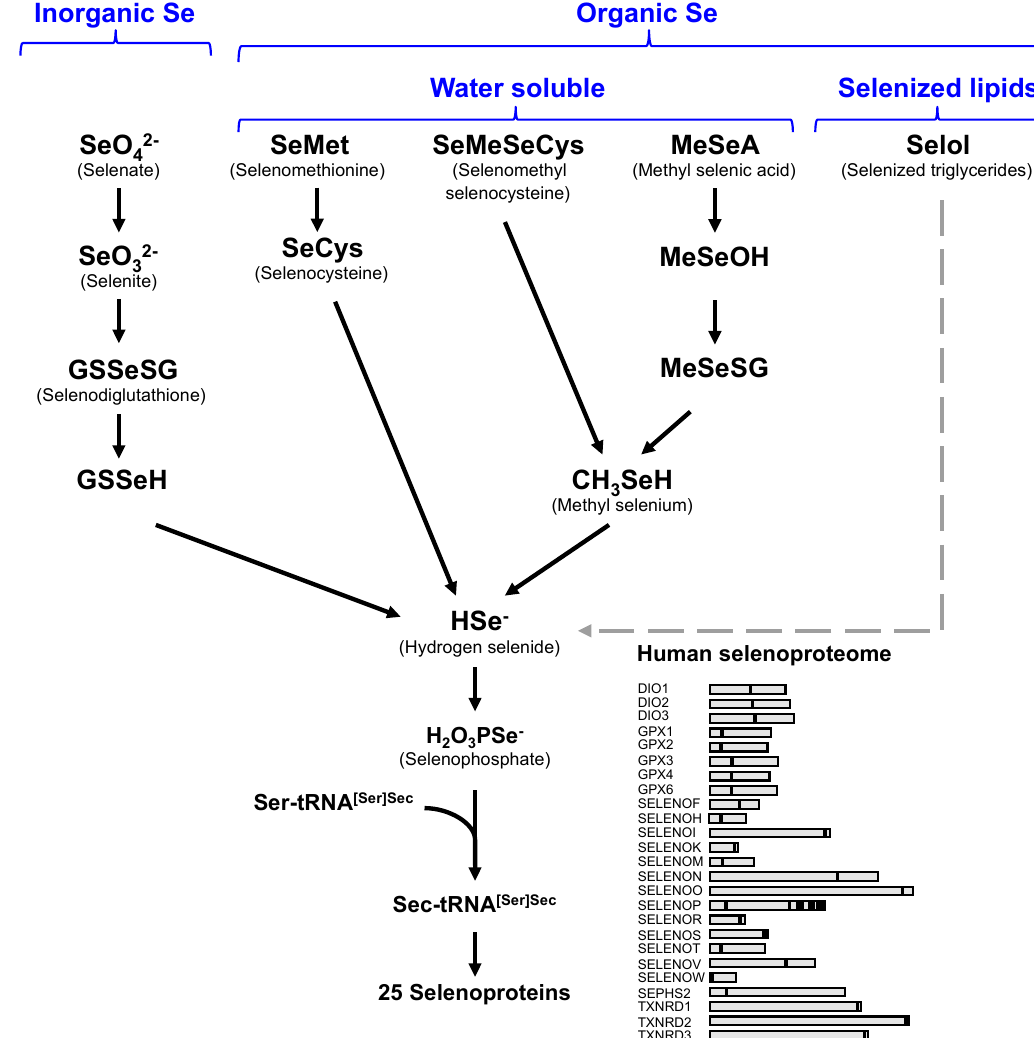
Figure 1. Representation of the various selenium metabolic pathways leading to selenoprotein synthesis. So far, every metabolic pathway towards selenoproteins converges to selenide. The dashed line suggest a putative metabolic pathway for selenium assimilation from selenized lipids.